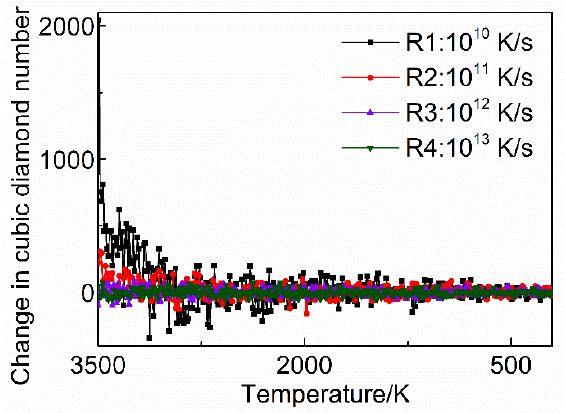
Figure 3. Crystallization rates for different cooling rates.